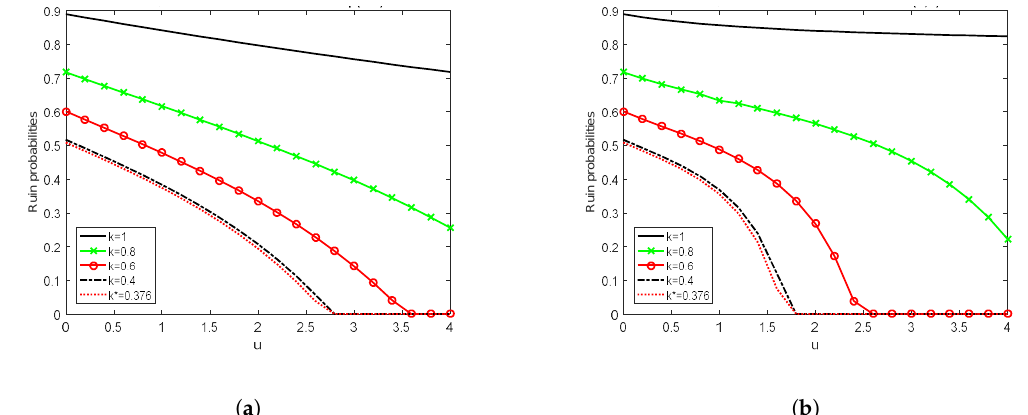
Figure 2. Ultimate ruin probabilities for the CLM compounded by proportional reinsurance and a constant force of interest; ( a ) CLM with interest force, Exp(0.5) claims; ( b ) CLM with interest force, Par(3,2)